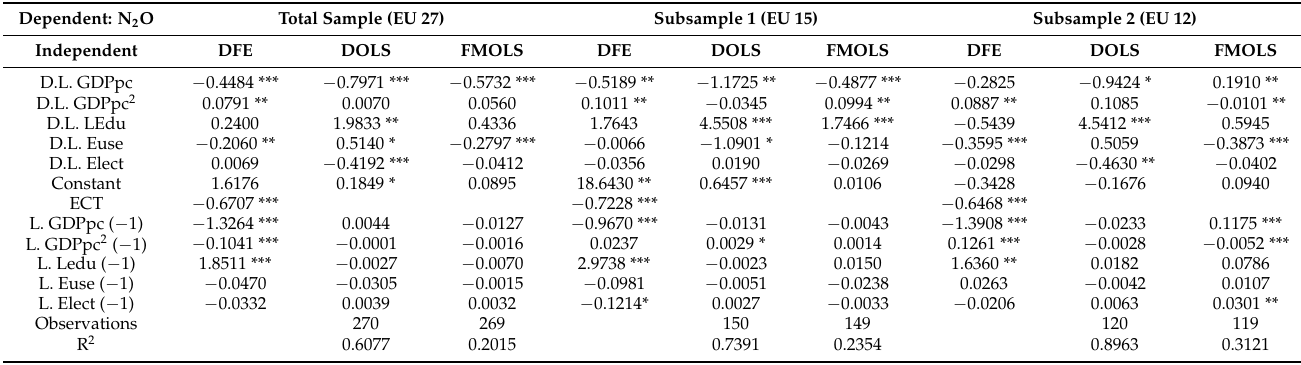
Table 8. DFE, DOLS, and FMOLS results for the total sample (EU-27), subsample 1 (EU-15), subsample 2 (EU-12) regarding Equation